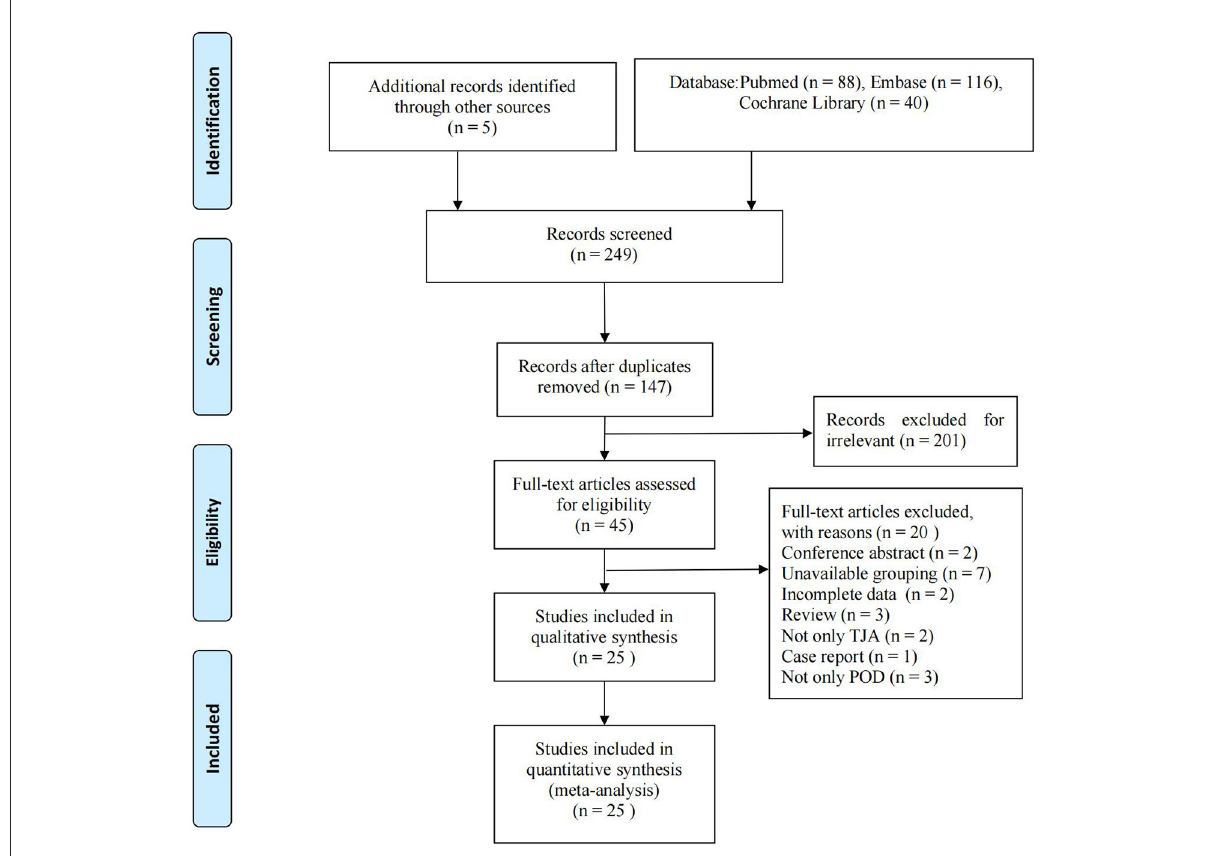
FIGURE1 Flow diagram details the process of relevant clinical study